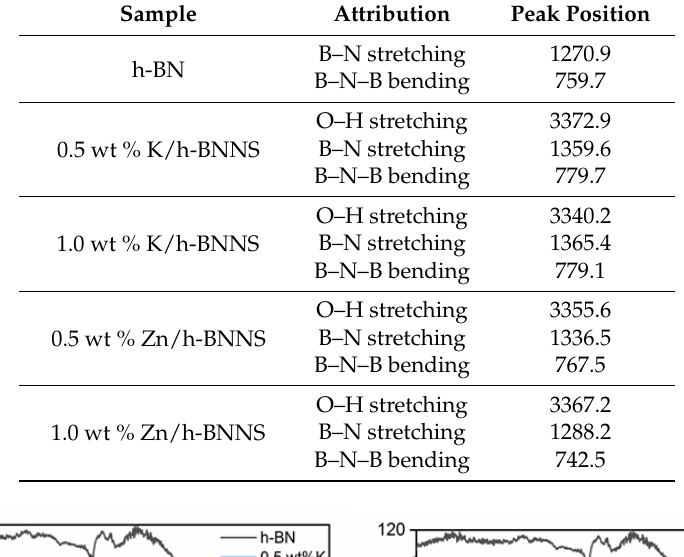
Table 5. FTIR bands attribution and peak positions of h-BN and h-BNNS intercalated with different concentrations of KCl and ZnCl 2.